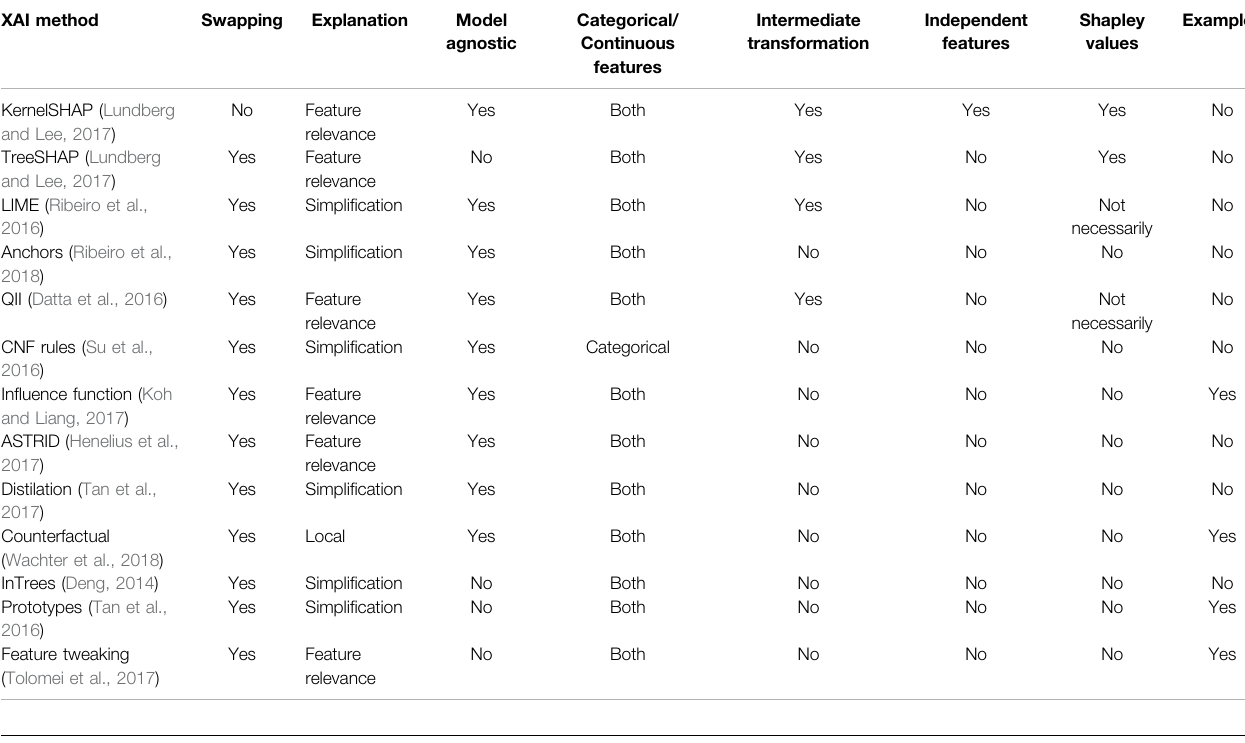
TABLE 3 | Advantages and disadvantages of the various kinds of explanations. Explanation Advantages Disadvantages Local explanations Examples